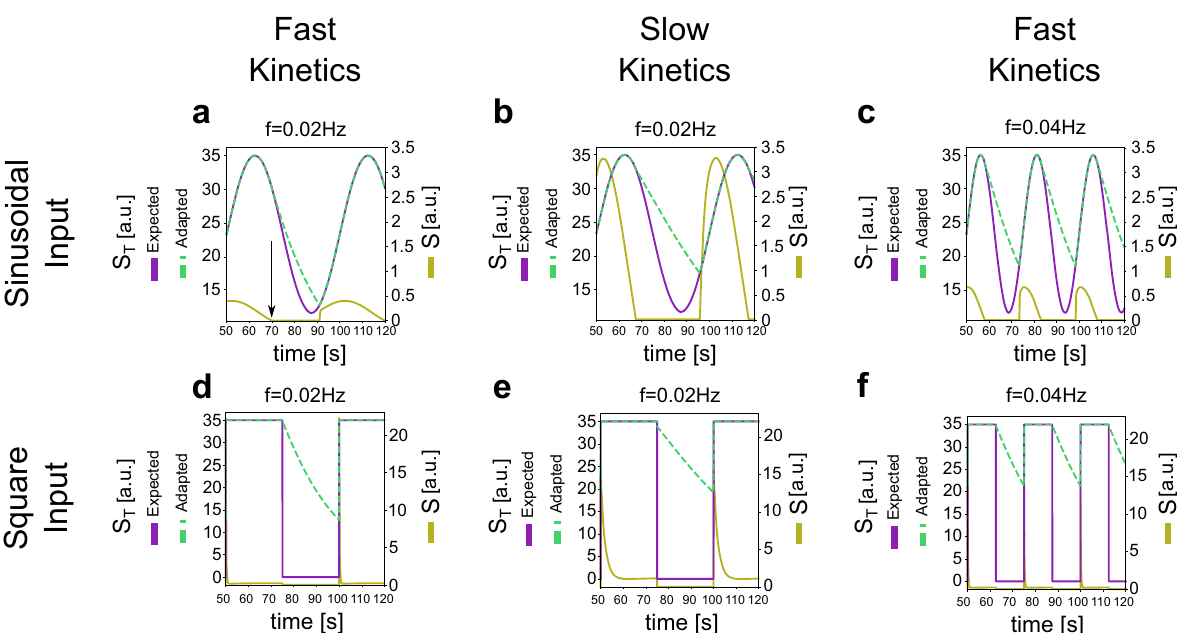
Fig. 4 Periodic control of the total amount of substrate. a – c Sinusoidal variation in S T . The expected variation in S T (purple solid) is given by S T = 35(1 + 0.5sin( ω t ))/1.5. The accomplished variation in S T (green dashed) is adapted as explained in the text. The scale on the right of the fi gure corresponds to S (free substrate, solid yellow). The horizontal axis starts at 50 s in order to include stationary variations only. The arrow (a) indicates the time at which complete depletion of S occurs (omitted in the other panels). a Parameter values: a 1 = 3.5; d 1 = 1; k 1 = 30; a 2 = 0.3; d 2 = 0.25; k 2 = 2.5; E 1T = 100; E 2T = 100; S T = 35. The frequency of stimulation is f = 0.02 Hz, corresponding to T = 50 s. b Parameter values are as in a with the exception of a 1 and a 2 that are multiplied by 0.1, resulting in a 1 = 0.35 and a 2 = 0.03. In this way, the system is overall slower than in a . For a slower CMC, the differences between expected and adapted are greater. The frequency of stimulation is f = 0.02 Hz. c Parameter values as in a but with a frequency of stimulation of f = 0.04 Hz, corresponding to T = 25 s. The stimulation is faster than in a , resulting in greater differences between expected and adapted S T . d – f Train of square pulses in S T . CMC parameter values as in a – c